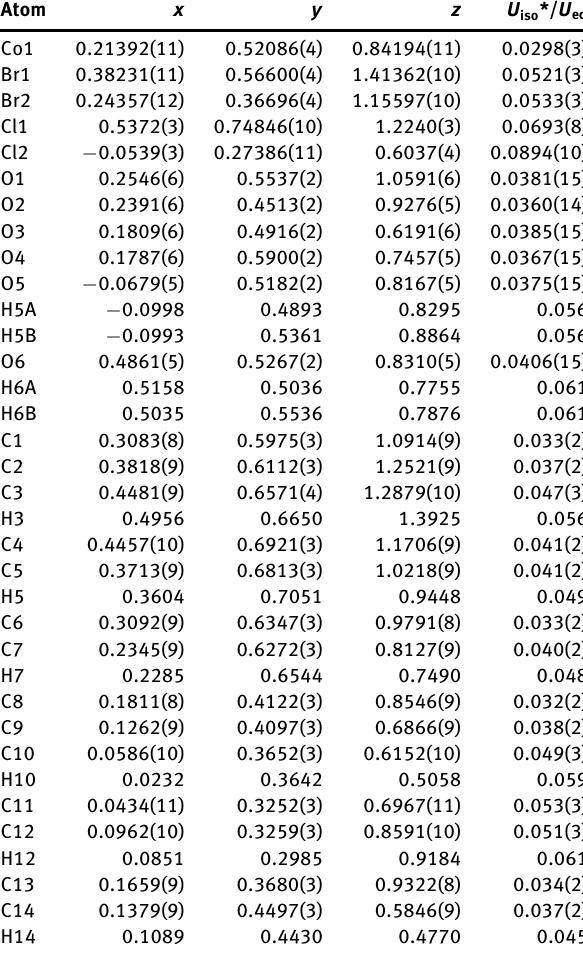
Table 2: Fractional atomic coordinates and isotropic or equivalent isotropic displacement parameters (Å 2